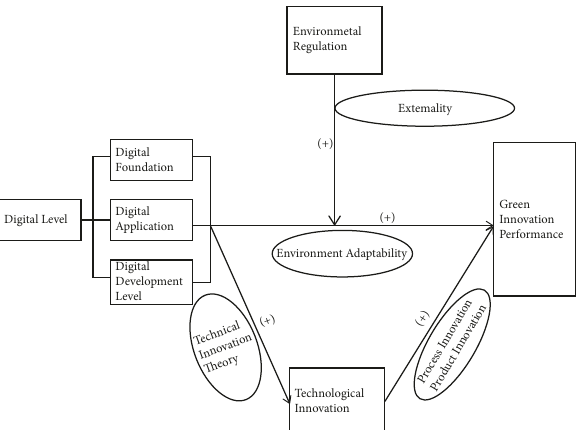
Figure 1: Hypothetical conceptual